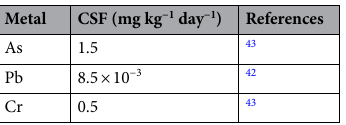
Table 4. Cancer slope factor values for As, Pb, and Cd.